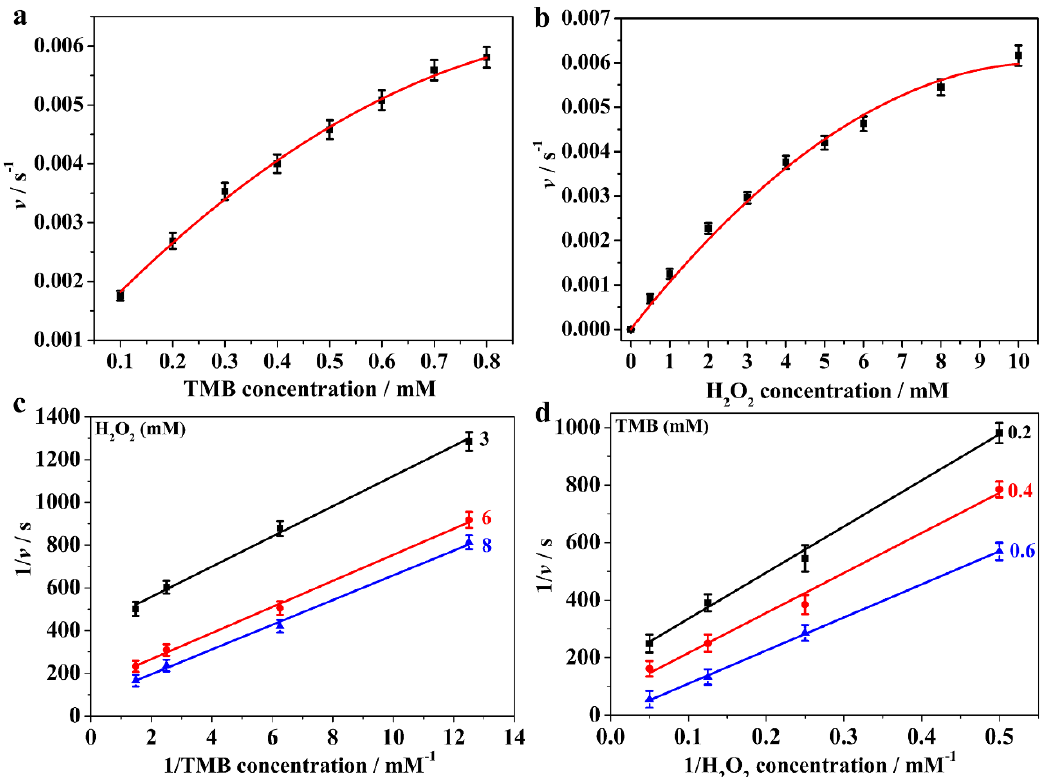
Figure 4. Steady-state kinetic analysis. The reaction velocity ( v ) was measured using 120 μg/mL of MoS 2 @CNNS(30) in 25.0 mM PBS (pH = 4.0) at room temperature. The TMB concentration was varied while the concentration of H 2 O 2 was 2.0 mM ( a ), the H 2 O 2 concentration was varied while the concentration of TMB was 0.8 mM ( b ), and the double-reciprocal plots with a fixed concentration of one substrate relative to varying the concentration of the other substrate ( c ) and ( d ) .